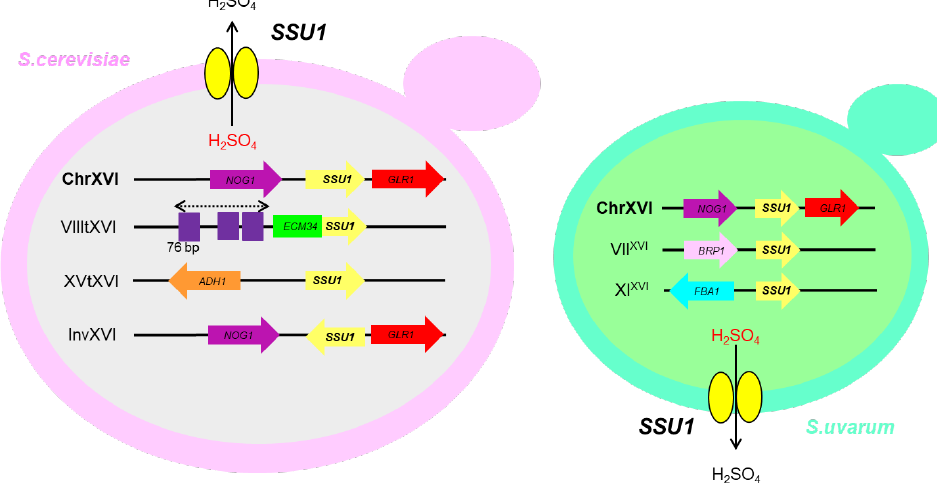
Figure 2. Schematic view of chromosomal rearrangements identified in sulphite-resistant strains of S. cerevisiae and S. uvarum species. VIIItXVI was generated by the homology among the promoters of ECM34 and SSU1 genes. Several 76-bp (in purple) repetitions were found in the promoters, together with a positive correlation between the number of 76-bp repeats and sulfite resistance. XVtXVI involves the ADR1 and FZF1 binding sites of the promoter of ADH1 and SSU1 genes, respectively. InvXVI was produced by microhomology between the sequences of the regulatory regions of the genes SSU1 and GCR1 genes. The translocations found in S. uvarum, VIIXVI and XIXVI, are likely mediated by microhomology regions between BRP1 - SSU1 and FBA1 - SSU1 , respectively.